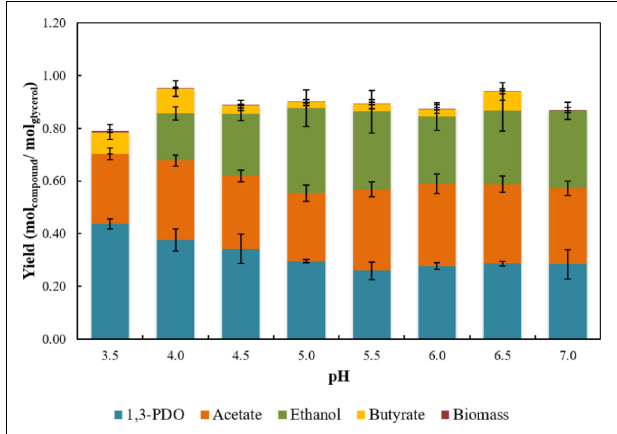
FIGURE 3 | Yields of 1,3-PDO, acetate, ethanol, and butyrate achieved in stationary phase from glycerol fermentation by strain ALE T in a range of pH from 3.5 to 7.0. Results are averaged from triplicates and the standard deviation values are displayed in